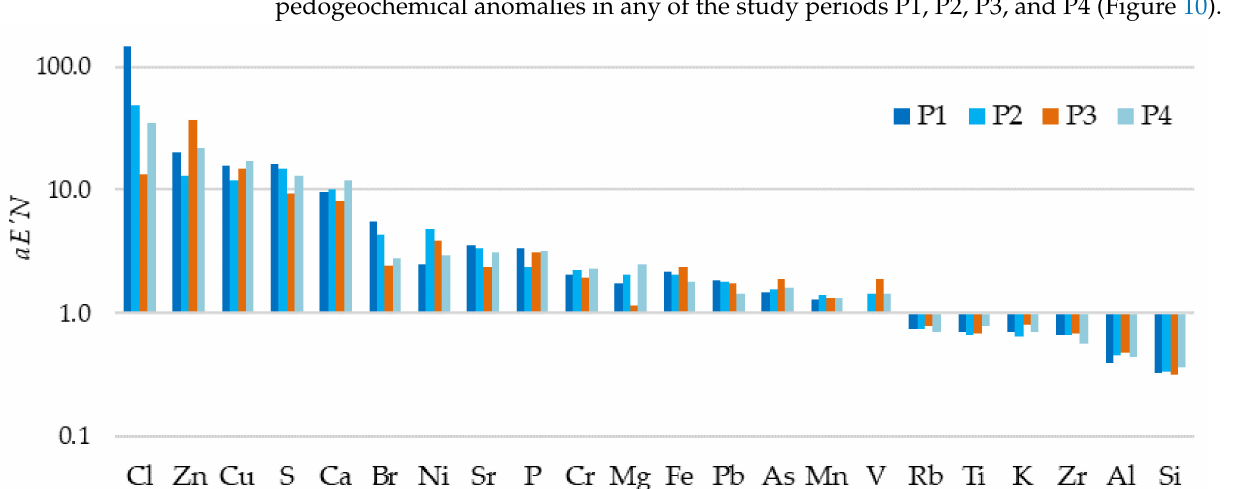
Figure 10. Median values of aE’N during study periods P1, P2, P3, and P4.